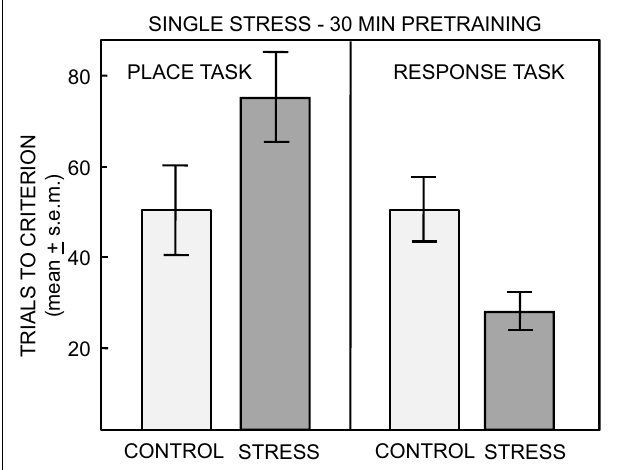
FIGURE 4 | Number of trials to reach criterion on the place and response task after no treatment or single restraint stress ending 30min prior to training. ANOVAS revealed a significant interaction of task by treatment. Pre-training single stress impaired learning on the place task and significantly enhanced learning on the response task (From Sadowski et al.,